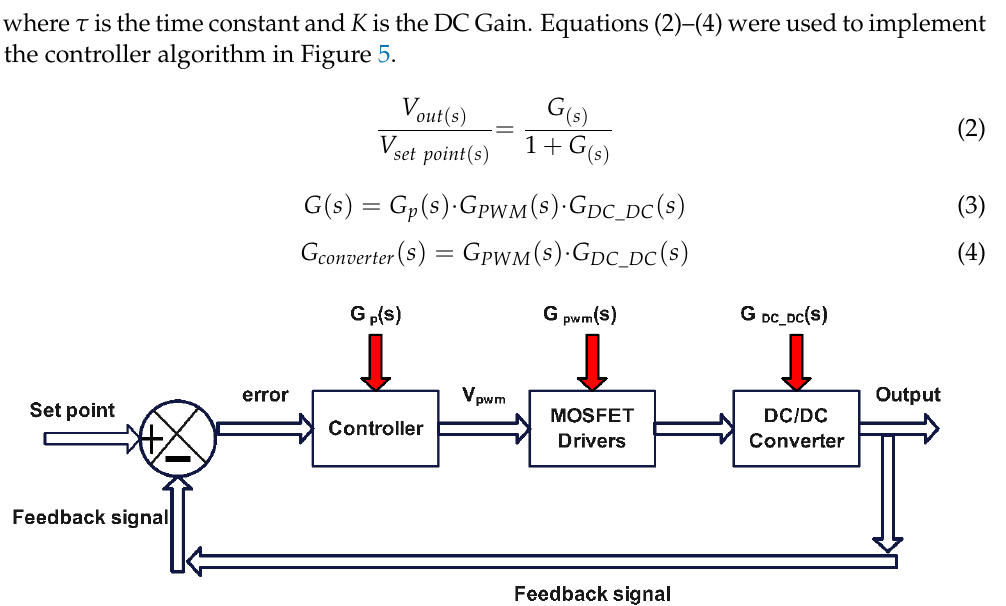
Figure 5. Multi-input DC/DC converter process with closed-loop controller.